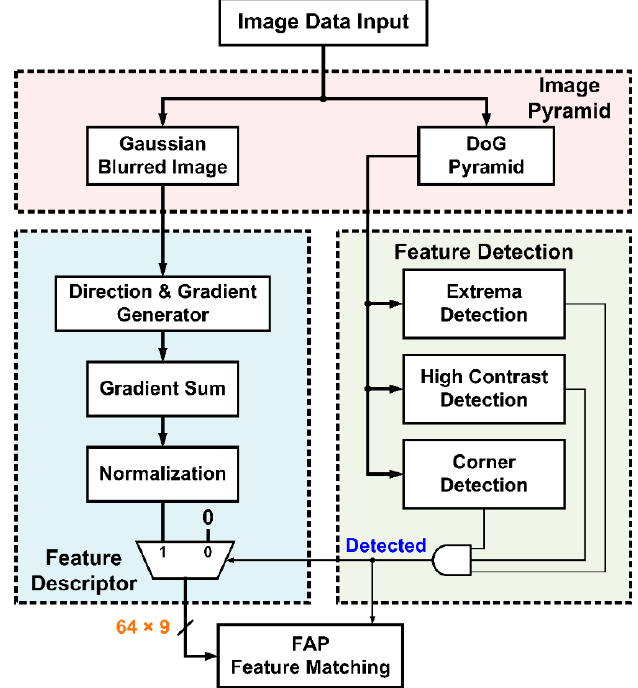
Figure 1. Building blocks of the proposed E-SIFT.